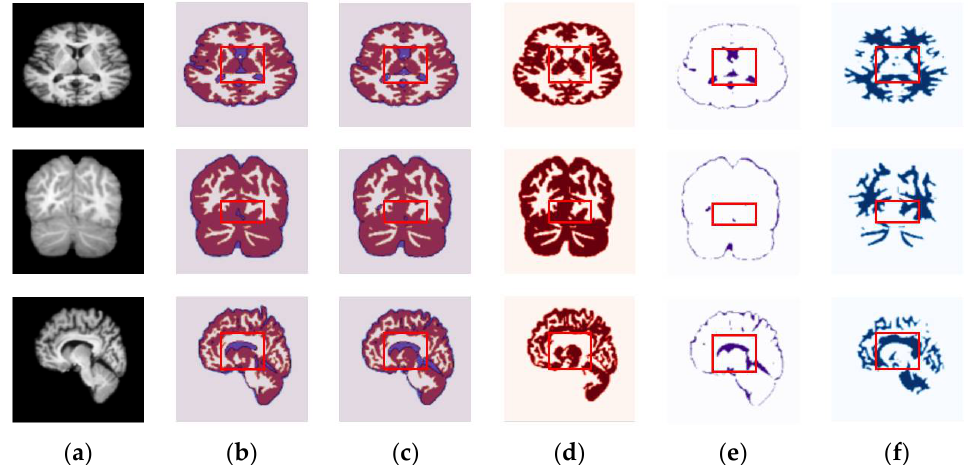
Figure 5. Randomly chosen test samples from brain MRI scans, showing segmentation results of the proposed method in all planes for the IBSR dataset: ( a ) original input images, ( b ) ground-truth map, ( c ) predicted maps obtained under the proposed method, ( d ) predicted binary maps of GM, ( e ) predicted binary maps of CSF, and ( f ) predicted binary maps of WM.